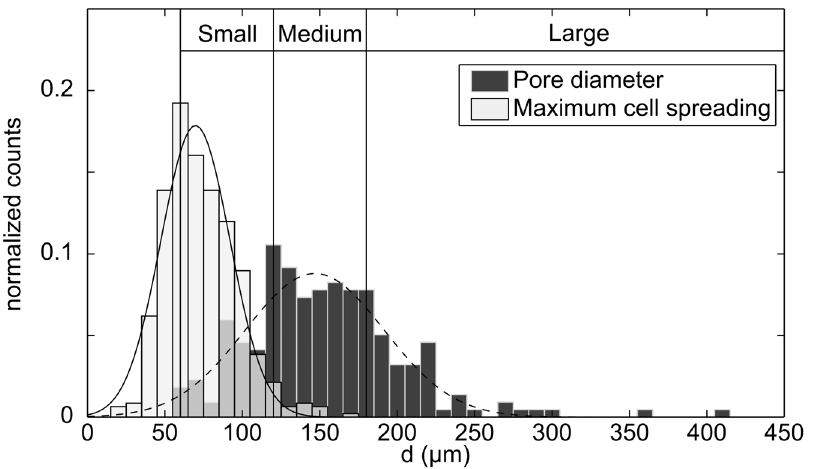
Figure 1. Maximal spreading length of fibroblasts and pore wall to wall distance within StarPEG-heparin cryogel. Maximal spreading length d cell,spread of the different human dermal fibroblasts are represented by white bars and wall to wall distance d pore,min of the pore analyzed in the scaffold by dark grey bars. The overlapping area is displayed in light grey. Gaussian fit was performed for maximum cell spreading (continuous line) and pore diameter (dashed line) distribution. The data was obtained by combining all the imaging performed on the starPEG-heparin cryogel (N pores . 100) and cells contained in pores (N cells . 200).’’